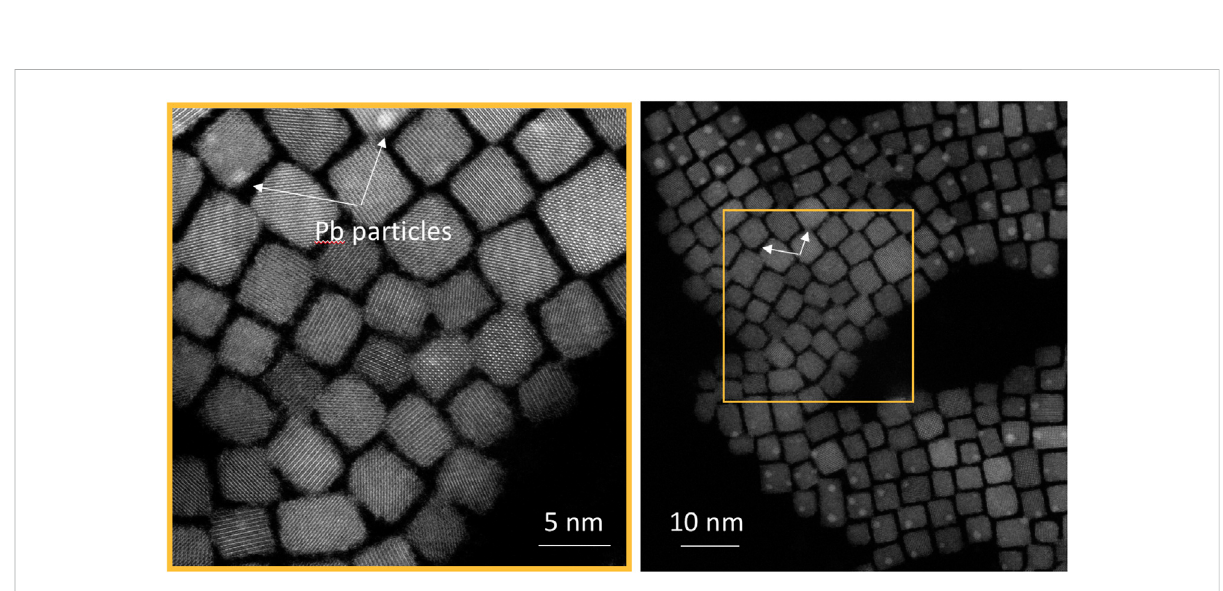
FIGURE 6 ThePbparticlespresentinthehigh-magni fi cationscanofCsPbBr 3 nanocrystals(whitearrowsintheleftpanel)arenotvisibleinthesubsequent low-magni fi cation image (right panel) due to their sublimation by the electron beam during the high-magni fi cation imaging and subsequent re- condensation in neighboring areas at a lower